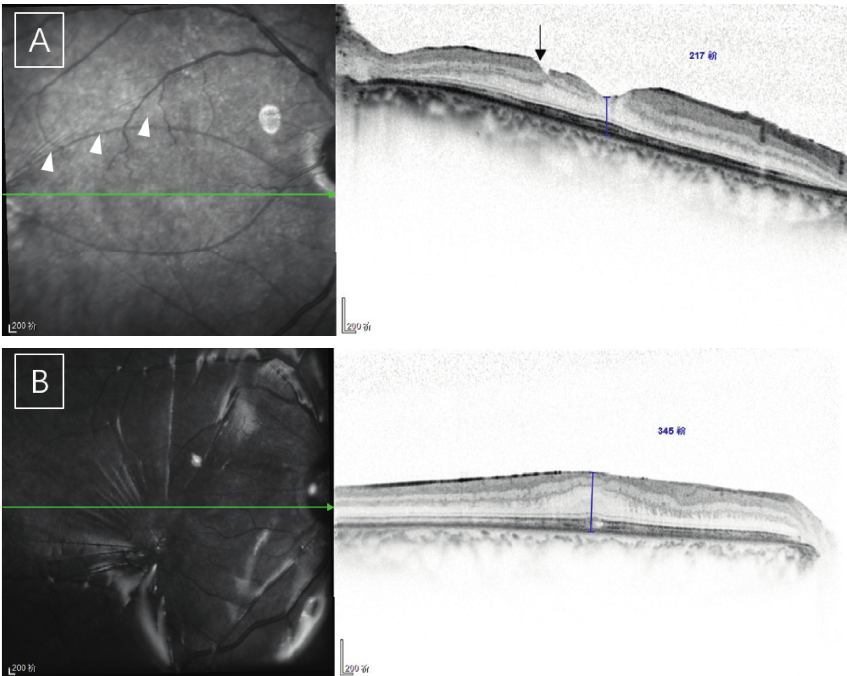
Figure 3: Spectral-domain optical coherence tomography scans of patients in the internal limiting membrane (ILM) peeling group. (a) The 5-month follow-up scan of a patient showing a smooth foveal surface. ILM peeling was carefully performed in the macular area and the area around the wound (white arrowheads). A pit caused by ILM peeling can be observed (black arrow). (b) Another patient developed an epiretinal membrane 3 months after the first pars plana